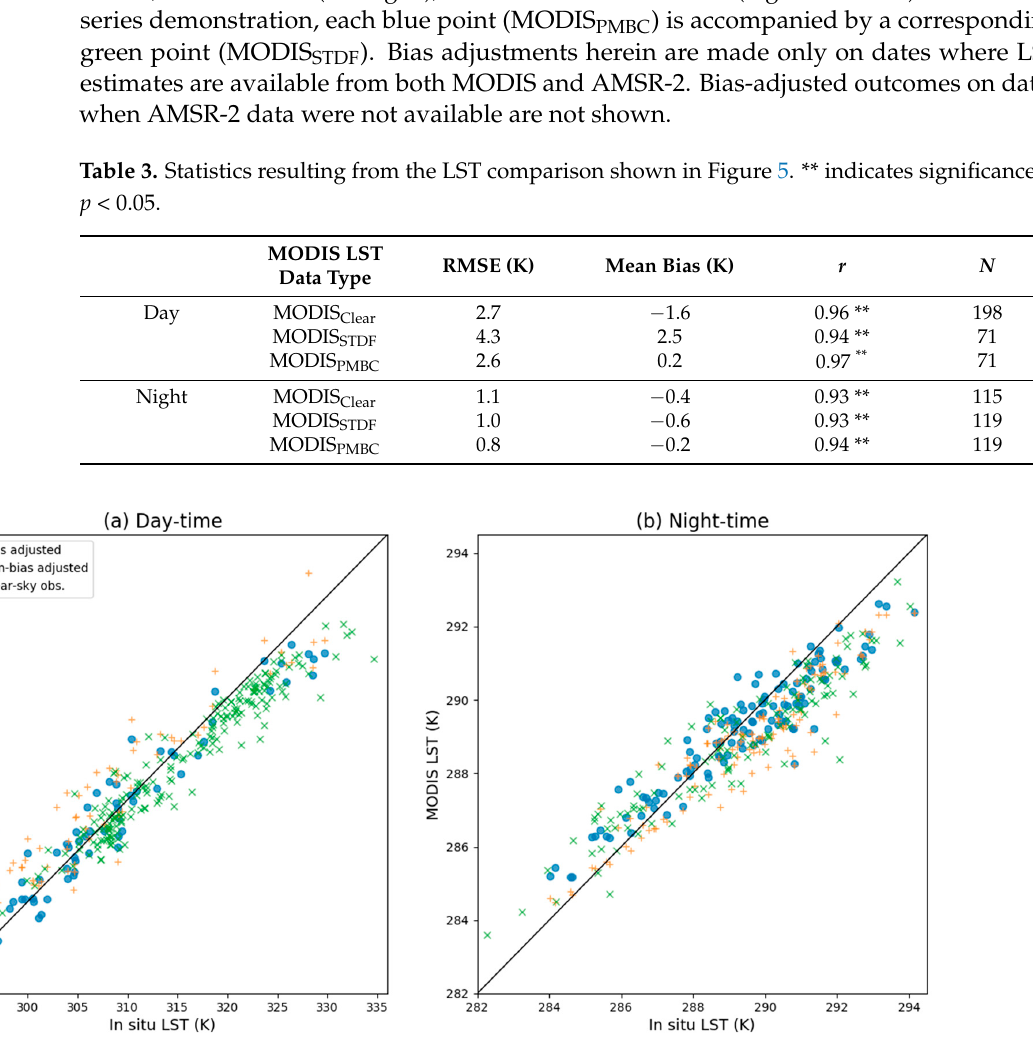
Figure 6. Time series of MODIS cloud gap filled daytime LSTs and corresponding in situ LSTs recorded at the locations of ( a ) Mast 1, ( b ) Masts 2 and 3 (averaged), and ( c ) Mast 4 of the ILRI Kapiti Research Station. Note that cloud gap filled LSTs are only shown when both Step 1 and Step 2 of the cloud gap-filling methodology were applied as detailed in Section 3 (“non-bias adjusted” and “bias adjusted” respectively). Dates marked by the box and arrows are those examined in Section 4.4.